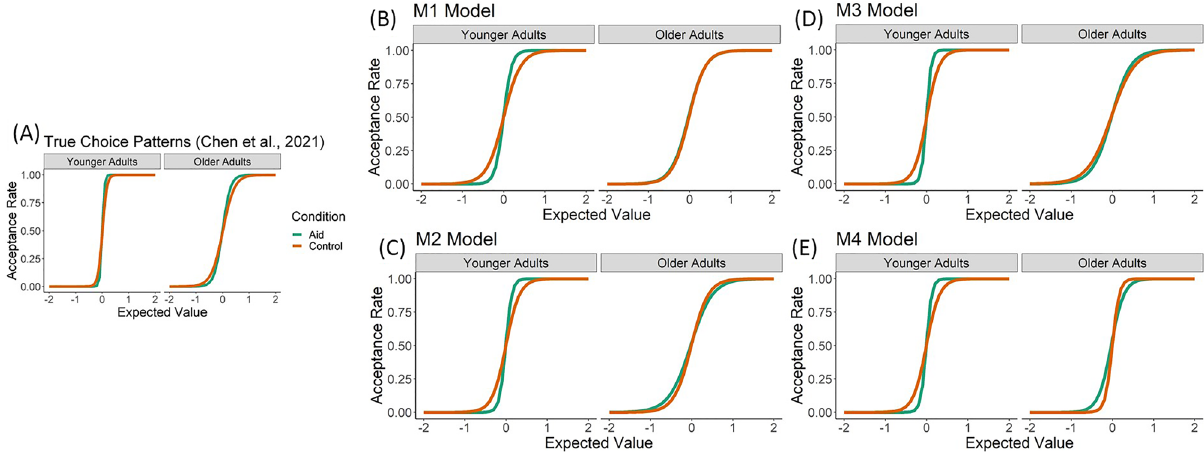
Figure 1. Logistic regression slopes (value sensitivity) for the empirical and simulated data sets. ( A ) The plot shows the empirical choice curves for younger and older adults by conditions [green indicating decision-aid condition and orange indicating control condition; adapted from Chen et al. (2021)]. Relative to younger adults, older adults showed shallower slopes near the point where the gamble’s expected value equals zero, indicating less sensitivity to expected value when making decisions. The decision-aid increased the slopes in both age groups; however, this effect was more pronounced in younger than older adults (Chen et al. 2021). The plots in ( B – E ) show the same logistic regression slopes fitted to the simulated choice data produced by the parameters for the four stDDMs that we compared. Only M3 generates the correct pattern for older adults. In older adults, M1 does not generate a difference between decision-aid and control trials, while M2 and M4 generate choices with less value sensitivity in decision-aid than control trials, which is the opposite of the empirical results.